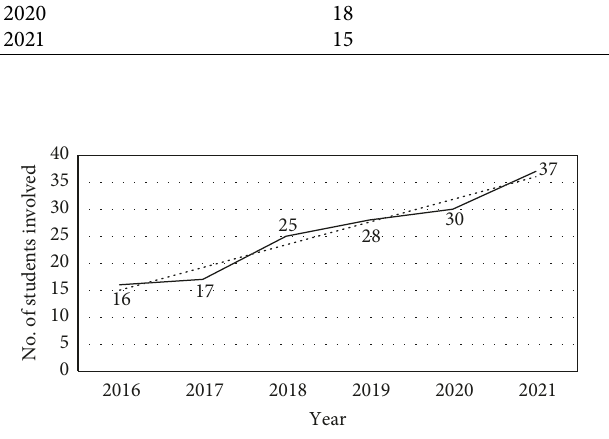
Figure 1: Impact of technical competition.